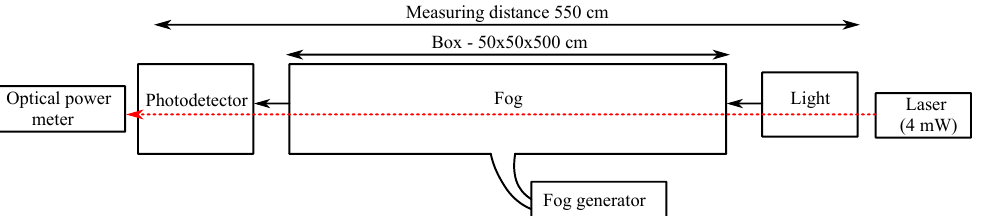
Figure 33. Octavia tail-light setup adjusted for scenario 5–fog.